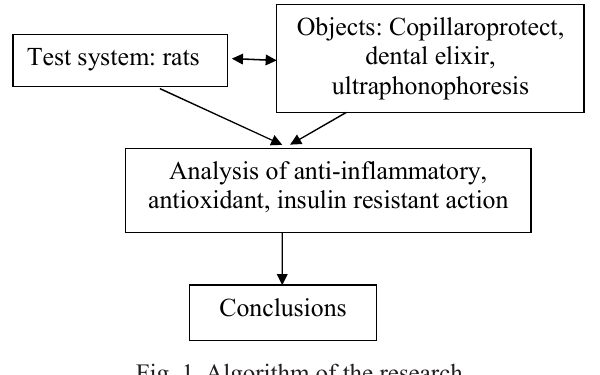
Fig. 1. Algorithm of the research